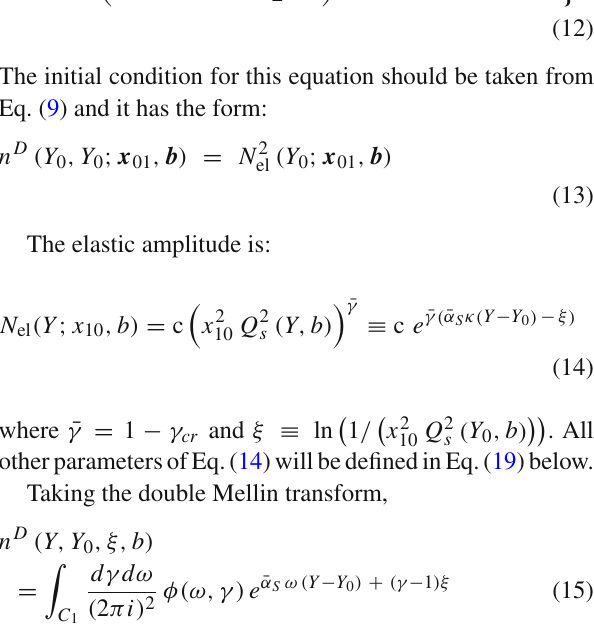
with χ (γ ) and κ are equal to